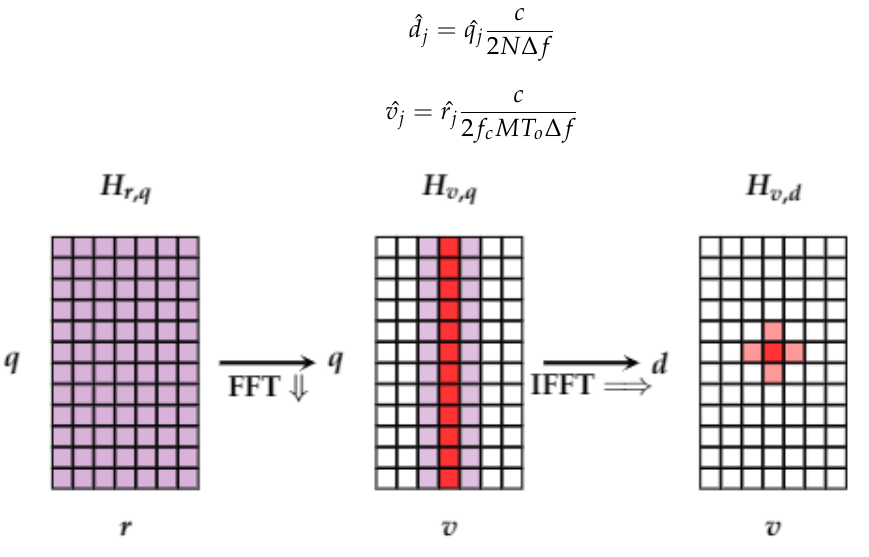
Figure 3. Two-dimensional (2D) periodogram processing. N (cid:62) N c and M (cid:62) N symb , where N symb denotes the total number of the transmitted symbols, and N and M are the FFT and IFFT length of the 2D periodogram, respectively. T o is the total duration of the OFDM